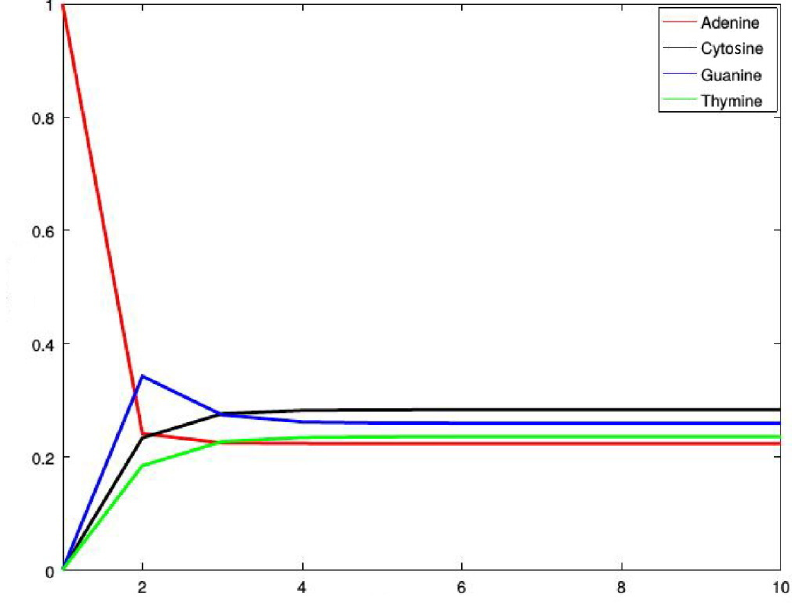
Figure 2. Probabilities of occurrences of the bases in consecutive steps starting from adenine.